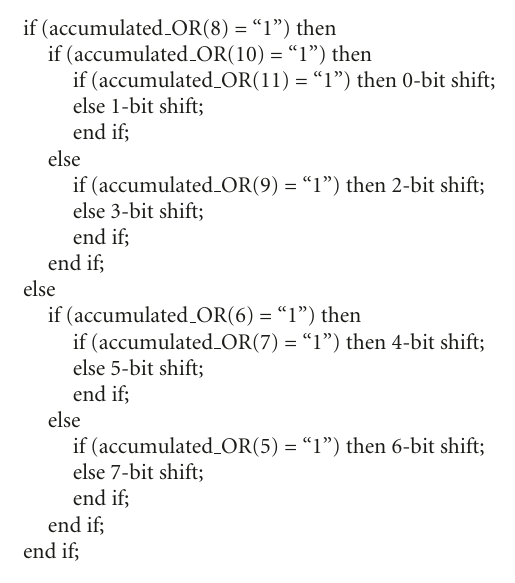
Algorithm 3: Binary search and barrel